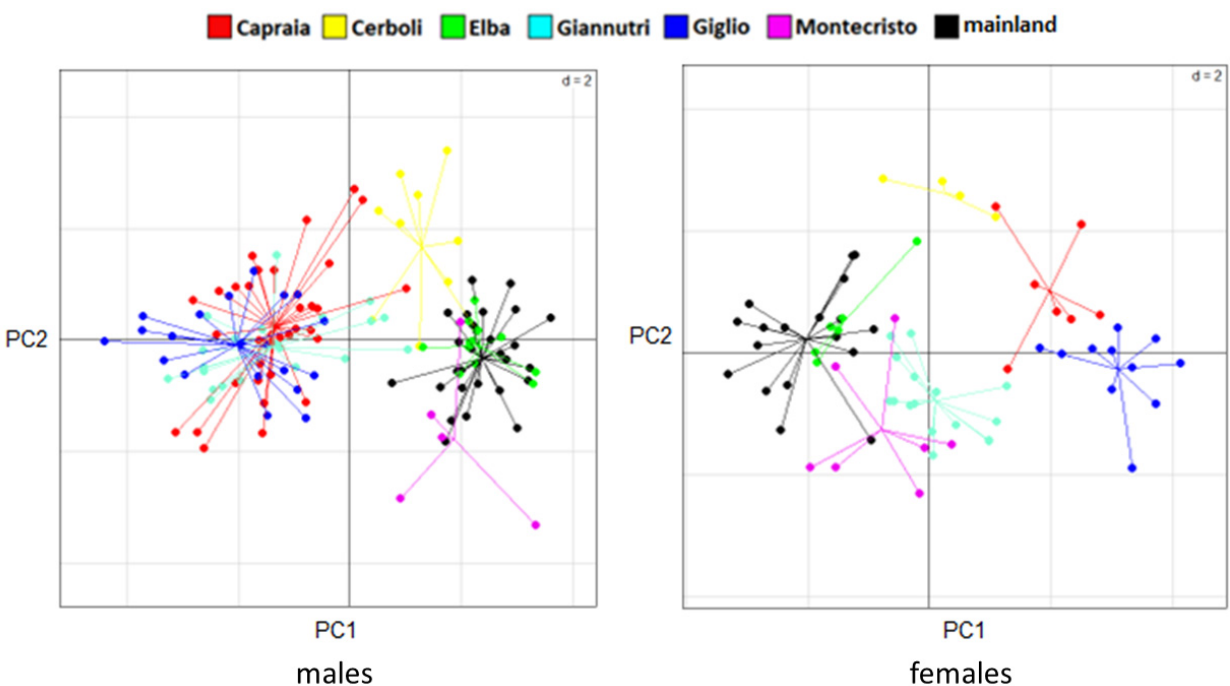
Figure 4. PCA results for males (on the left) and females (on the right). PC1 on the horizontal axes and PC2 on the vertical axes are shown, accounting for 46.83% and 13.12% of the total variance in males, respectively, and 41.23% and 15.36% of the total variance in females, respectively. Table 2. MANOVA results. We reported the degrees of freedom (df), Pillai’s Trace, approximate F value (Approx F), number of degrees of freedom in the model (Num df), number of degrees of freedom associated with the model errors (Den df) and p -value.